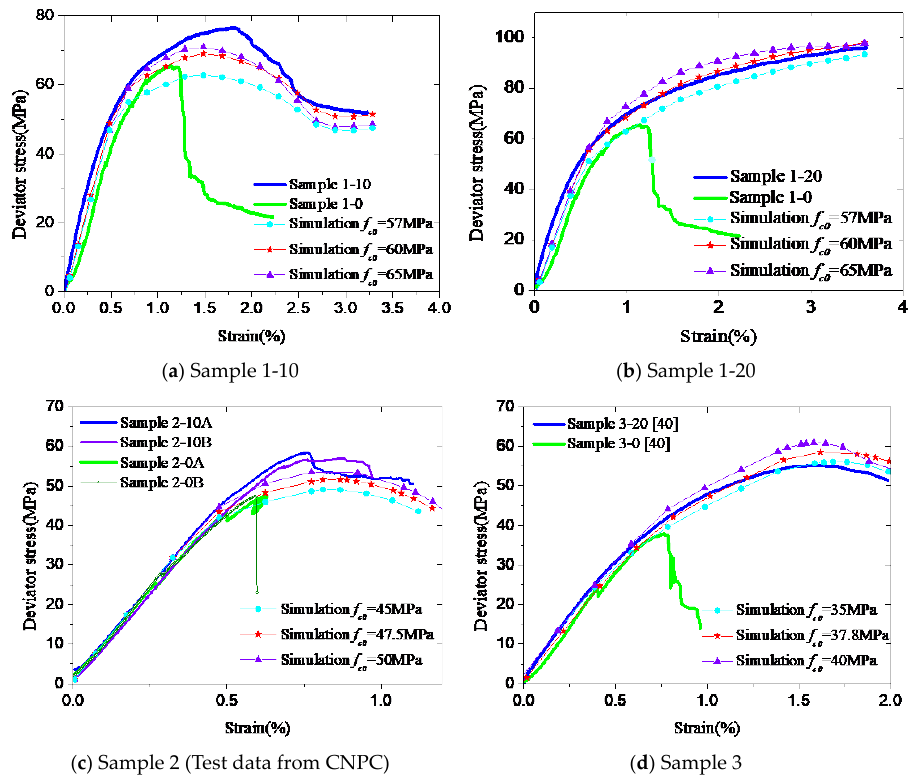
Figure 9. Effects of strength. ( a ) Sample 1-10, ( b ) Sample 1-20, ( c ) Sample 2, ( d ) Sample